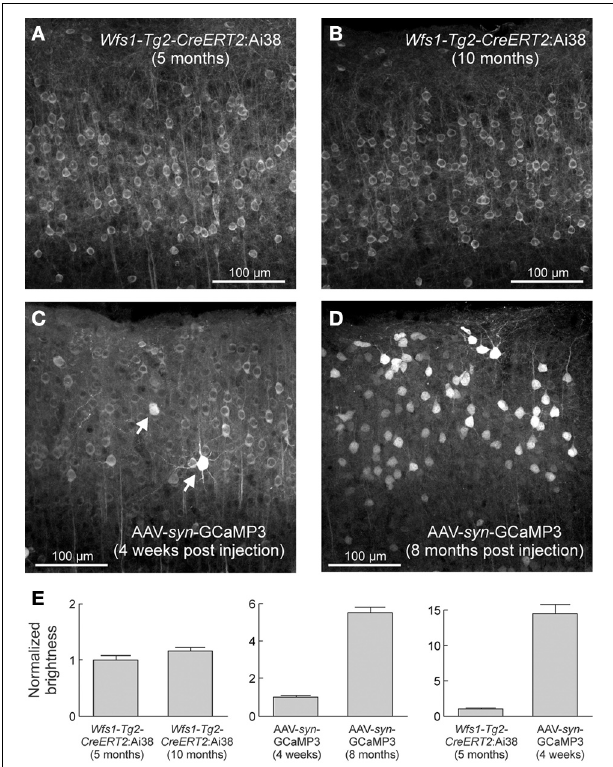
FIGURE 3 | Stable expression levels in the Ai38 ROSA26-GCaMP3 mouse line over months. Native GCaMP3 fluorescence in layer2/3 excitatory neurons of visual cortex from Wfs1-Tg2-CreERT2:Ai38 mice (A,B) and adult wild-type mice injected with AAV-syn-GCaMP3 (C,D) . (E) Quantification of neuronal brightness. Error bars correspond to SEM. From (Zariwala et al., 2012), with